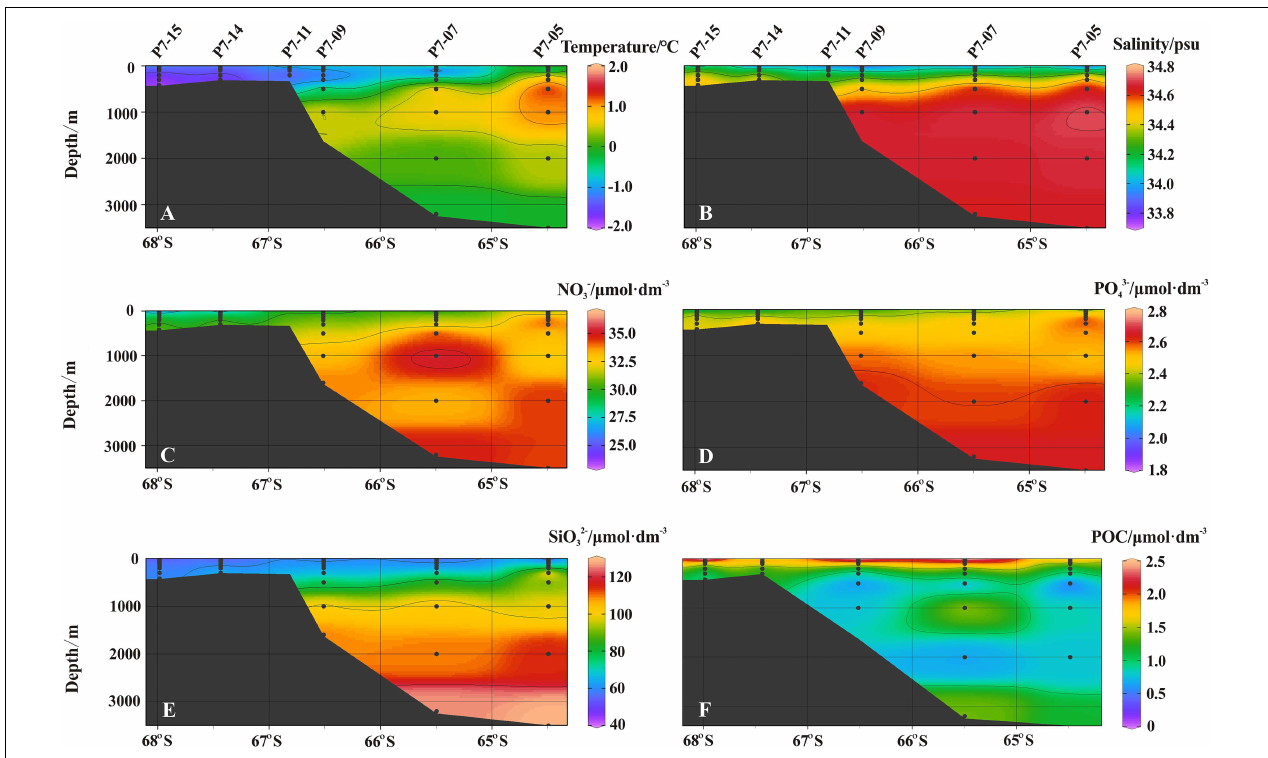
FIGURE 2 | The sectional distribution of (A) temperature ( ◦ C), (B) salinity (psu), (C) nitrate ( µ mol dm − 3 ), (D) phosphate ( µ mol dm − 3 ), (E) silicate ( µ mol dm − 3 ), and (F) POC ( µ mol dm − 3